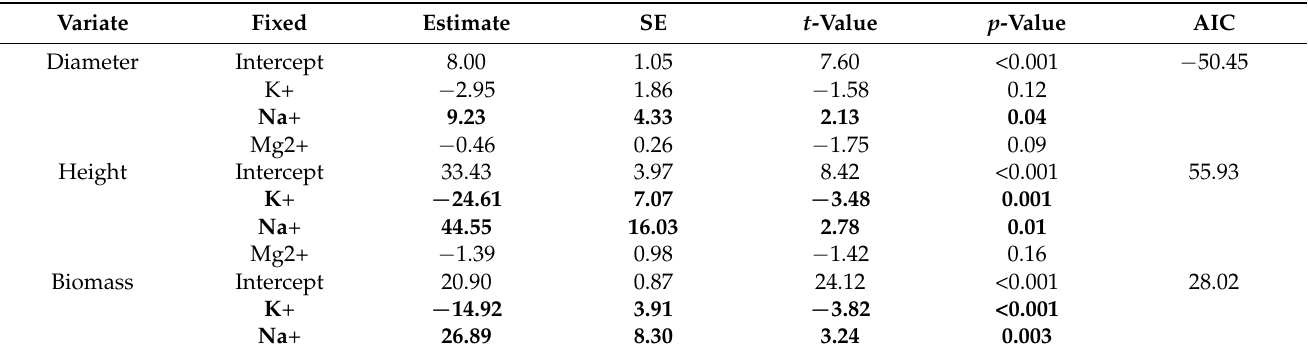
Table 2. The summary of SRMs for plant growth (diameter, height, and biomass) and BCs.